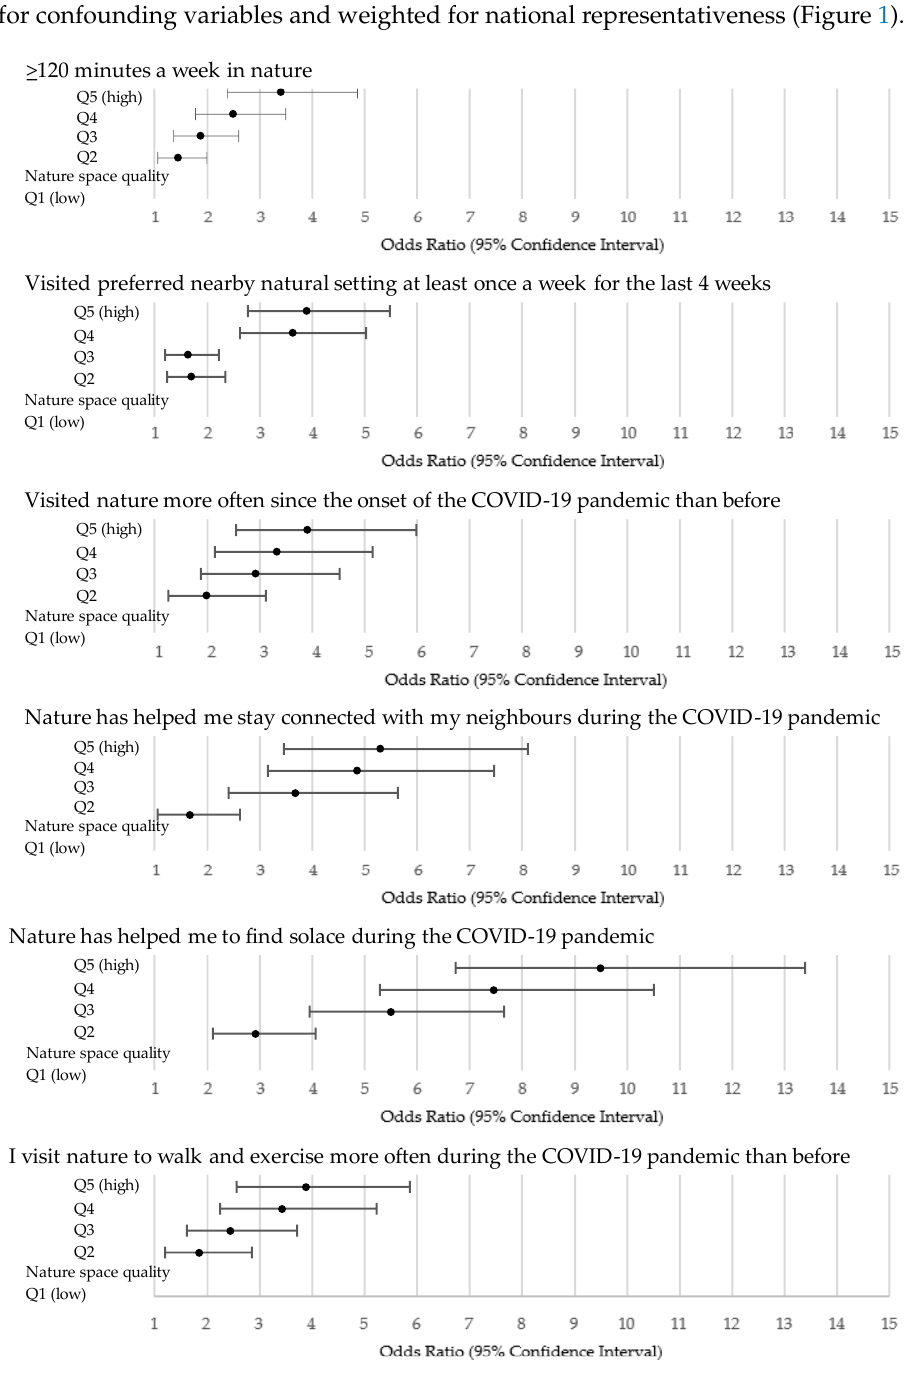
Figure 1. Adjusted associations between nature space total quality scores and visitation and felt benefits, weighted for national representativeness.